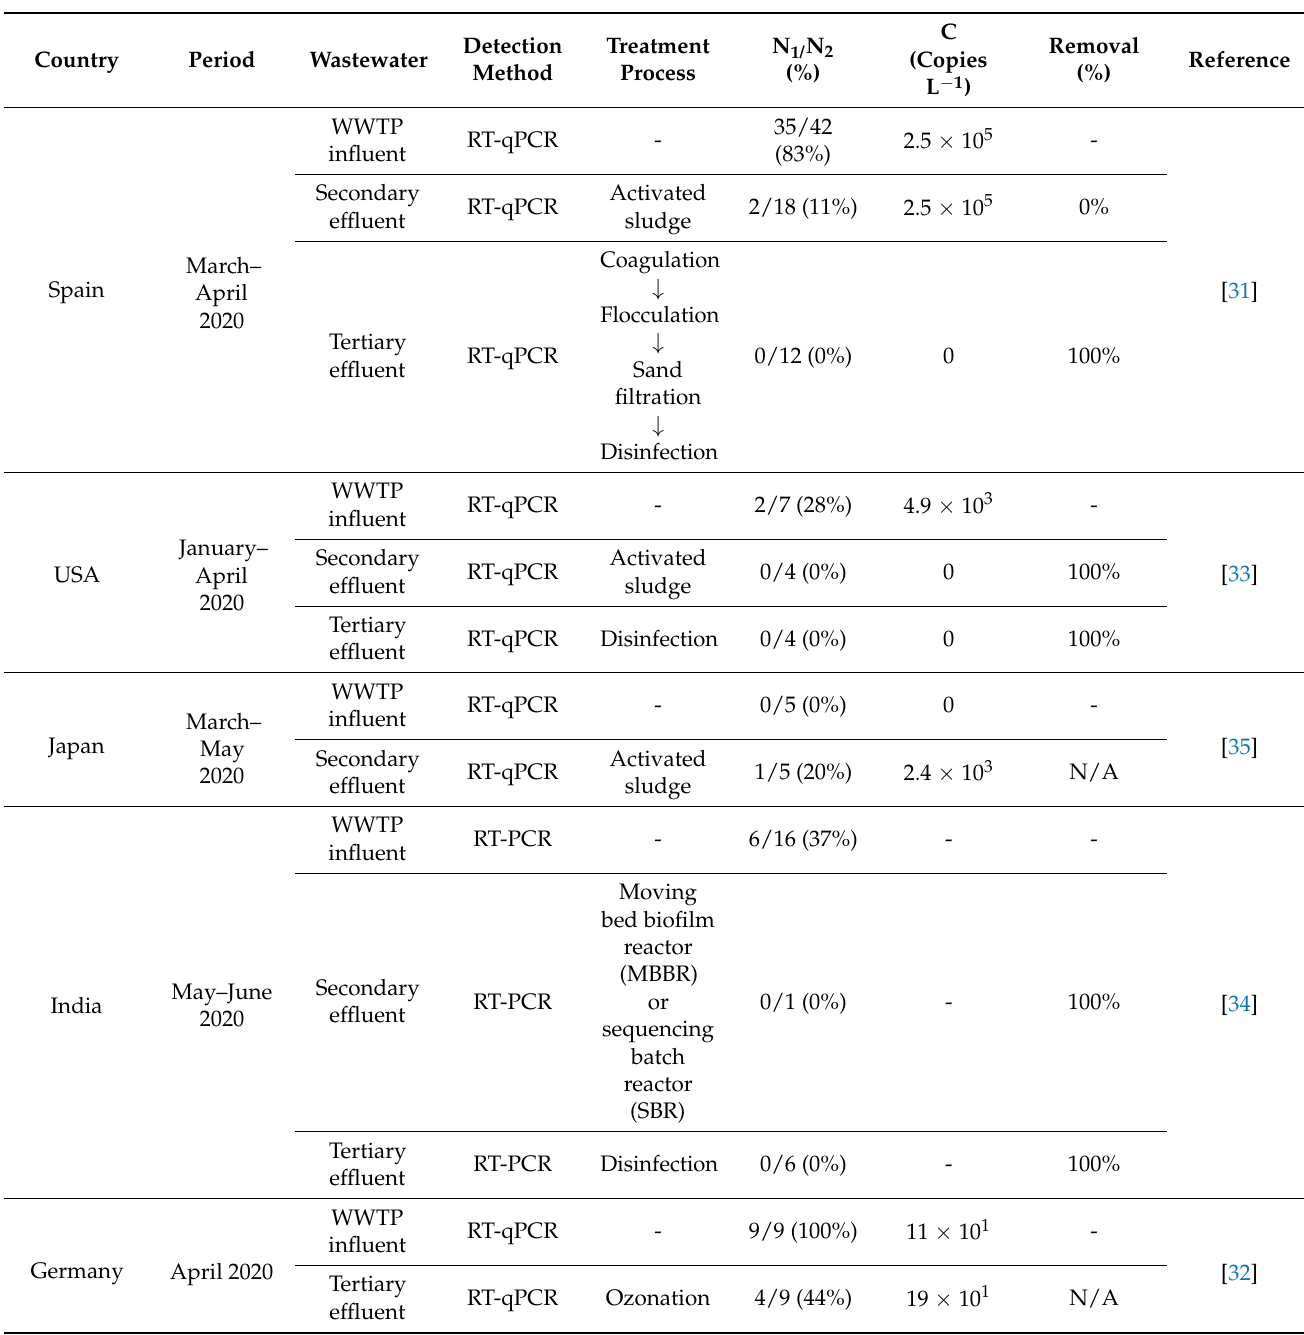
Table 1. Prevalence of SARS-CoV-2 RNA in